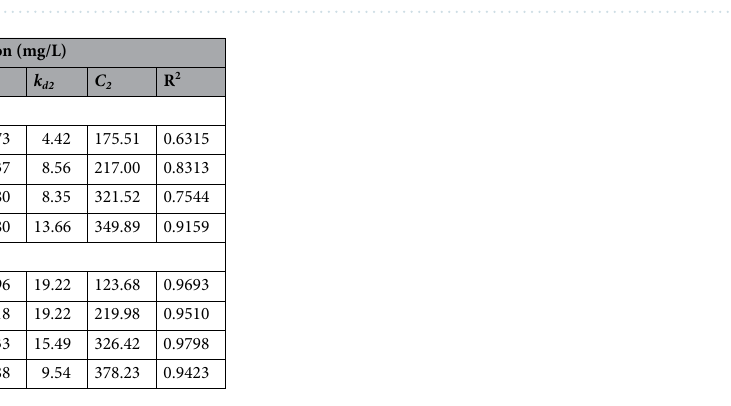
Table 3. Parameters of intraparticle diffusion model for removal of TB and BPA using FGS2 at different initial dye concentrations [pH: 3, agitation speed: 300 rpm, and solution temperature: 25 °C].